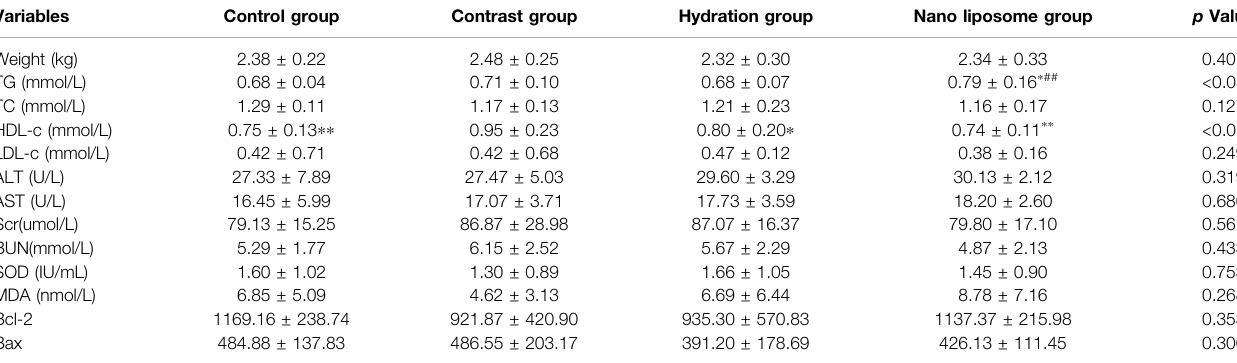
TABLE 3 | Baseline characteristics and serum biochemical and oxidative stress apoptosis parameters of rabbits in the four groups. Variables Control group Contrast group Hydration group Nano liposome group